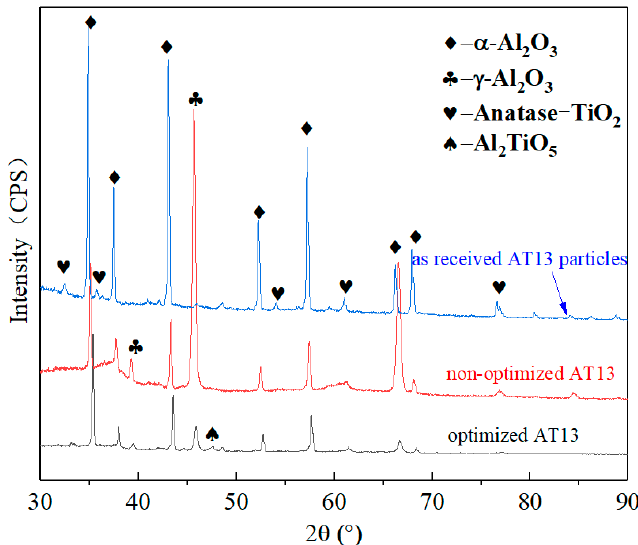
Figure 7. XRD patterns of as-received AT13 powders and the AT13 coatings prepared at optimized and nonoptimized parameters.